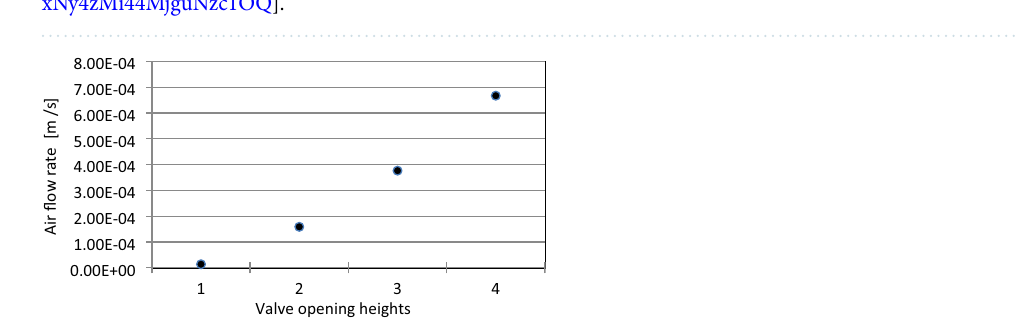
3 m, 3 h 2.69 10 2 − − = ×